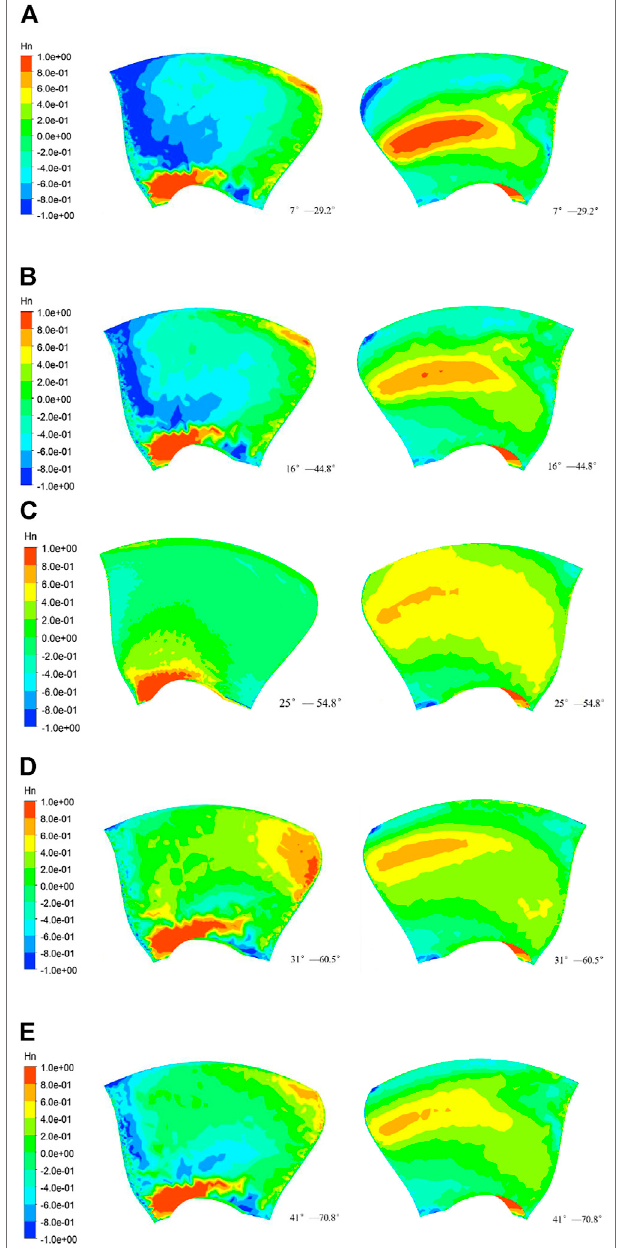
FIGURE 8 | Hn distribution of the blade under the fi ve coassociated working conditions. The left side is the working surface, and the right side is the back side. (A – E) are OP1, OP2, OP3, OP4, and OP5, respectively.